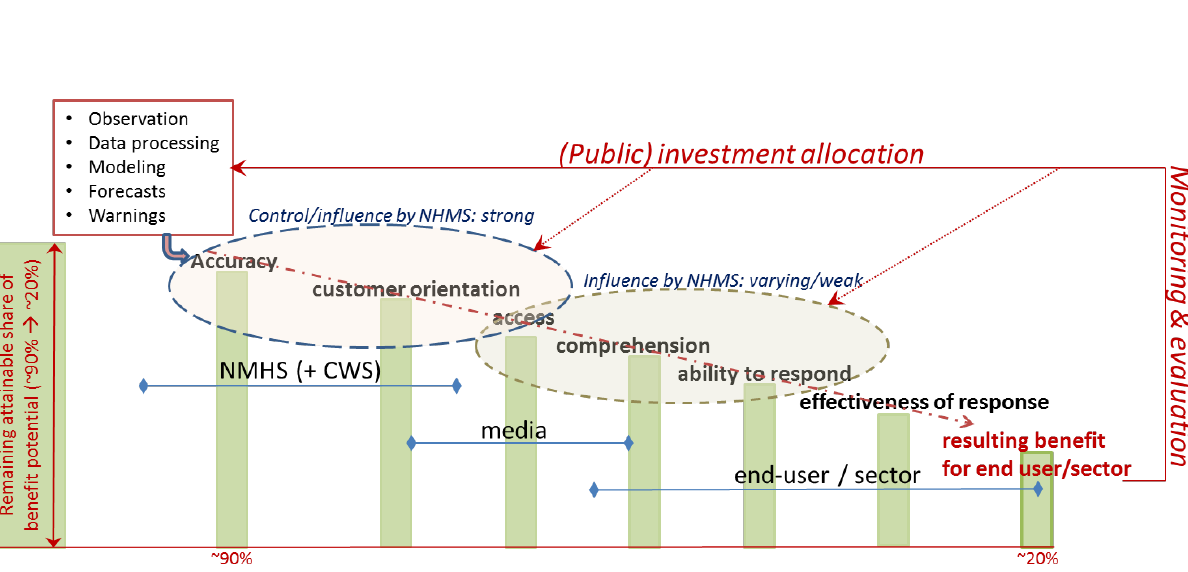
Figure 2. The weather service chain, its information decay and feedback possibilities for improving steps in the weather service chain; CWS denotes “commercial weather